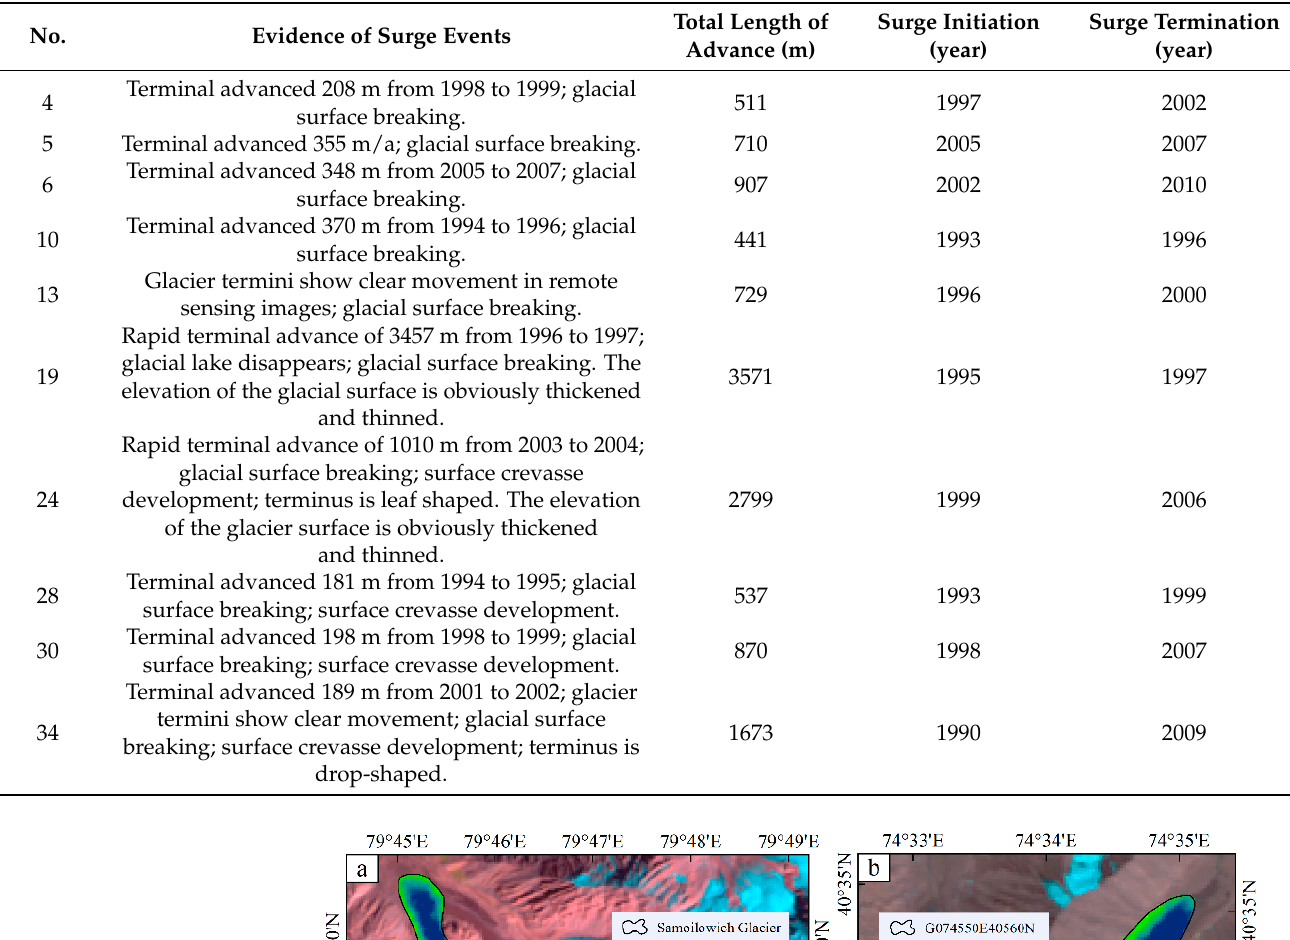
Table 2. Detailed information on each surging glacier in the Tien Shan region including evidence of surge event, total length of advance (m), surge initiation (year), and surge termination (year).